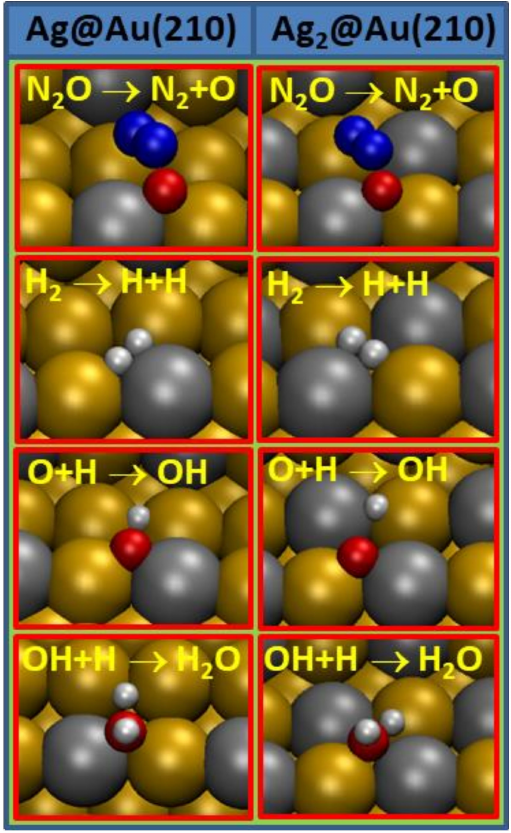
Figure 4. Transition states structures for the steps involved in the N 2 O hydrogenation on Ag@Au(210) and Ag 2 @Au(210) surfaces. Red color is used for oxygen, white for hydrogen, blue for nitrogen, grey for silver and ochre for gold